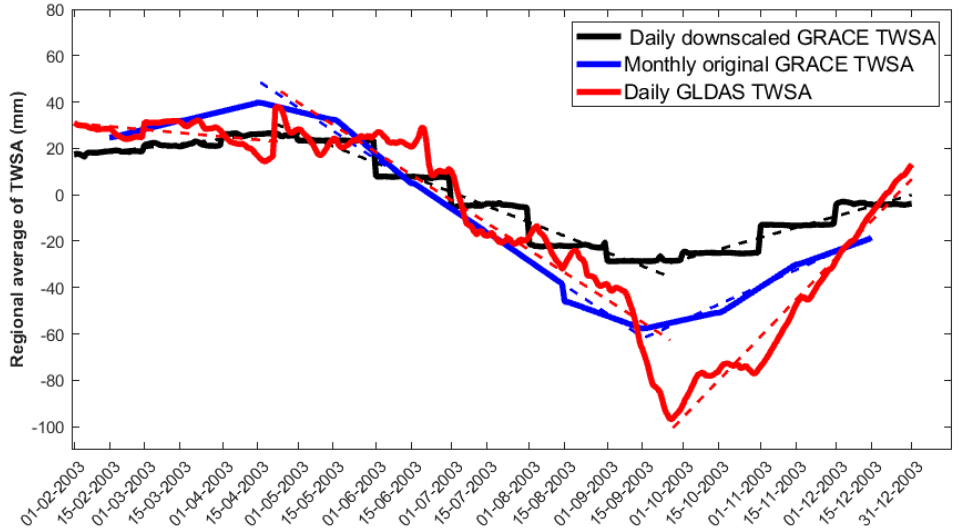
Figure 9. Daily time series of downscaled GRACE TWSA (black colour) vs. monthly time series of original GRACE TWSA before downscaling (blue colour), across study area from February to December 2003 [mm]. Dash lines show the seasonal trend.